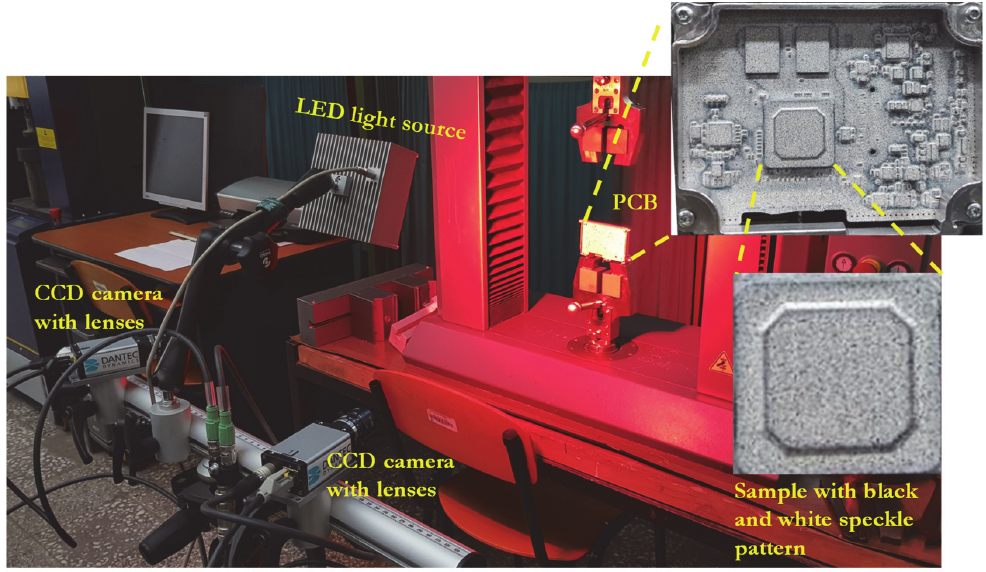
Figure 4: Experimental setup and PCB with black and white speckle